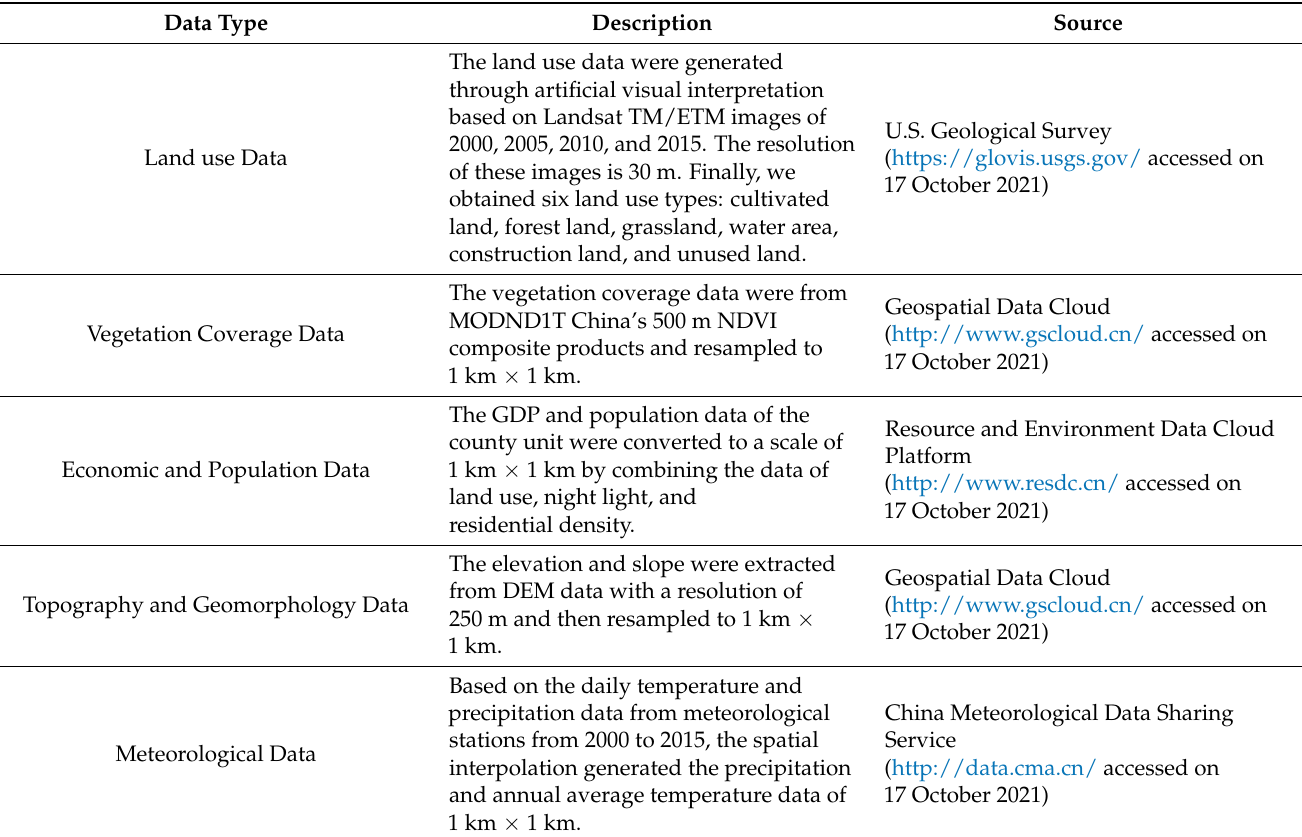
Table 3. Sources of graphic image